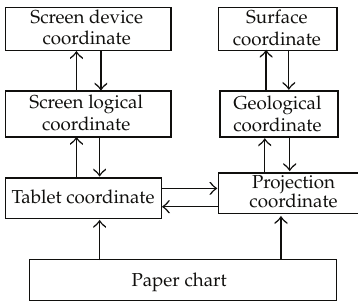
Figure 3: The conversion of